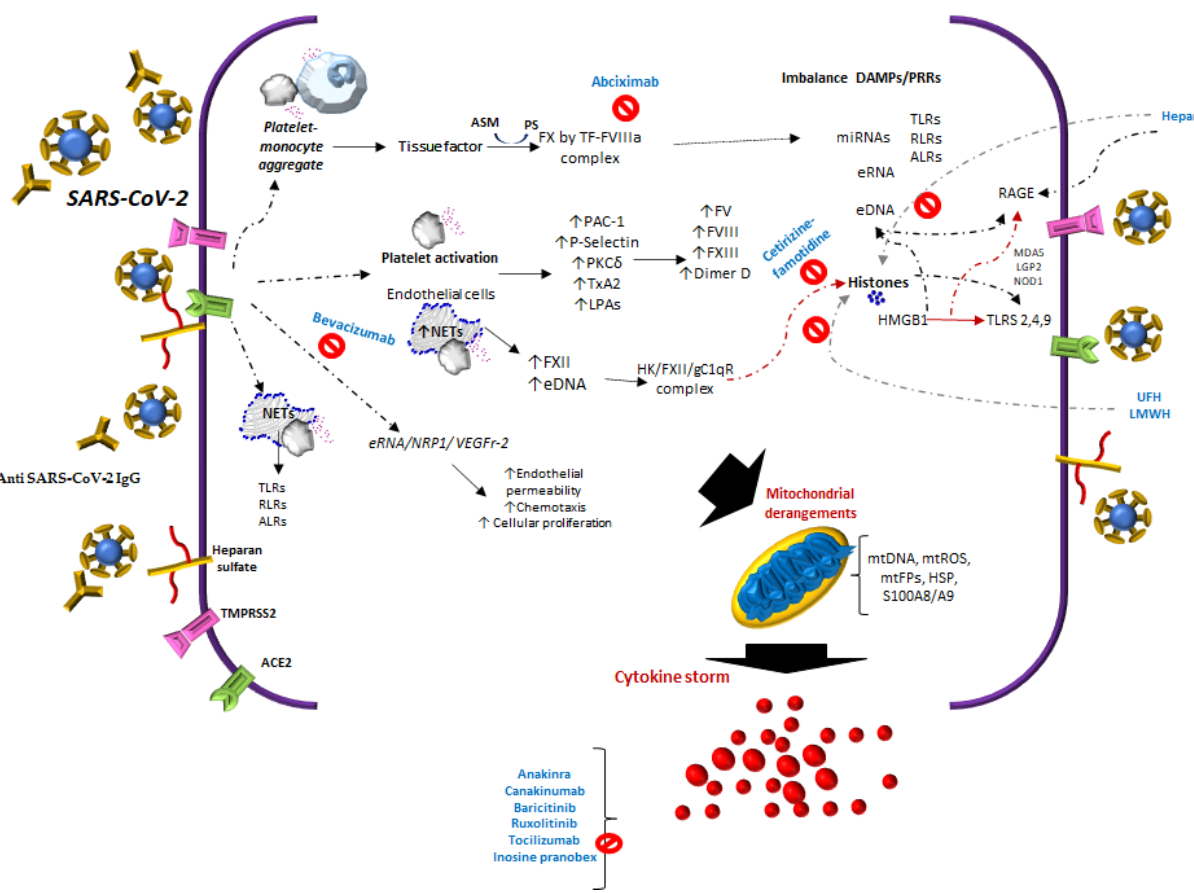
Figure 1. The reported studies of COVID-19 infer that there are multiple activation or inhibition routes in platelets and endothelium, this involves the release of tissue thromboplastin (TF), with the participation of monocyte-platelet, neutrophil-platelet aggregates, complement-TF-NETs, and histones. In addition, to immune complexes SARS-CoV-2 spike/anti-spike IgG, anti-PF4/heparin IgG antibodies and antiphospholipid antibodies.